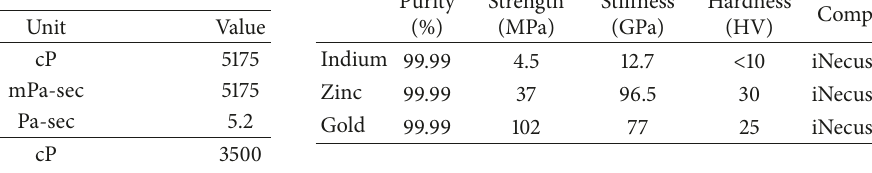
Table 1: Specifications of polydimethylsiloxane (SYLGAD 184, Dow Corning Co. Ltd., USA).